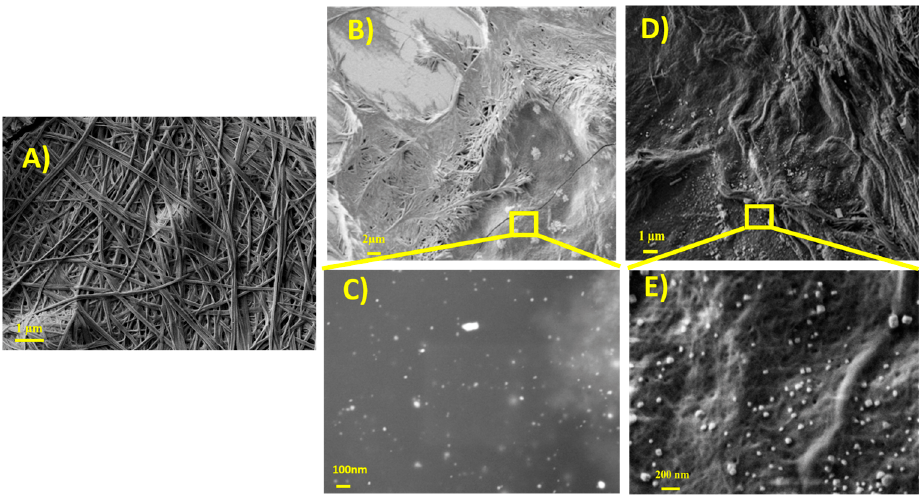
Figure 4. SEM images of ( A ) native hydrogel; ( B ) hgel@AgNPs-SDS; ( C ) hgel@AgNPs-SDS at high magnification; ( D ) hgel@AgNPs-3MPS; and ( E ) hgel@AgNPs-3MPS at high magnification.